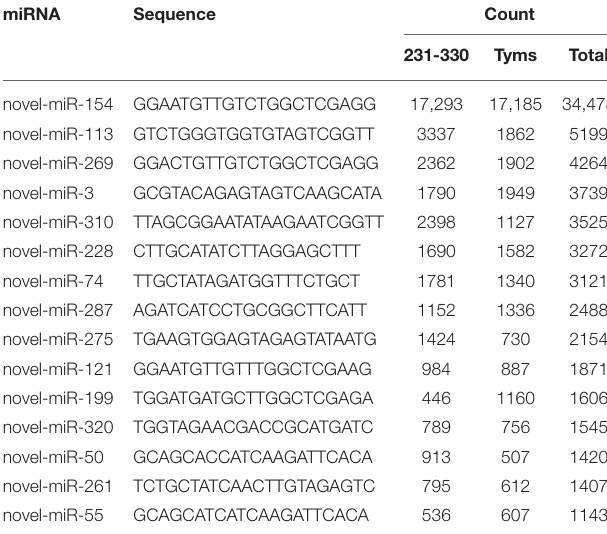
TABLE 2 | The most highly expressed novel